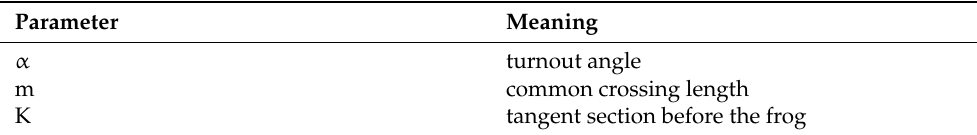
Table 4. Turnout parameters.